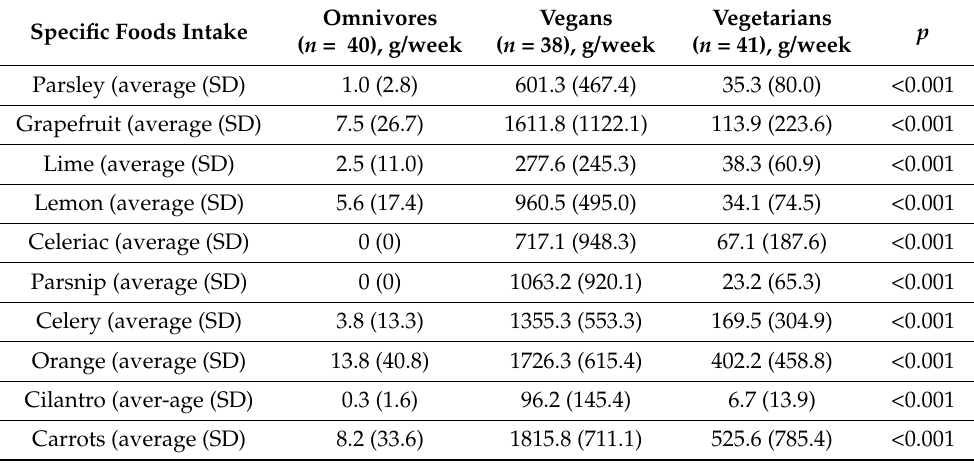
Table 3. Main foods rich in furocumarins consumed by the studied population. Specific Foods